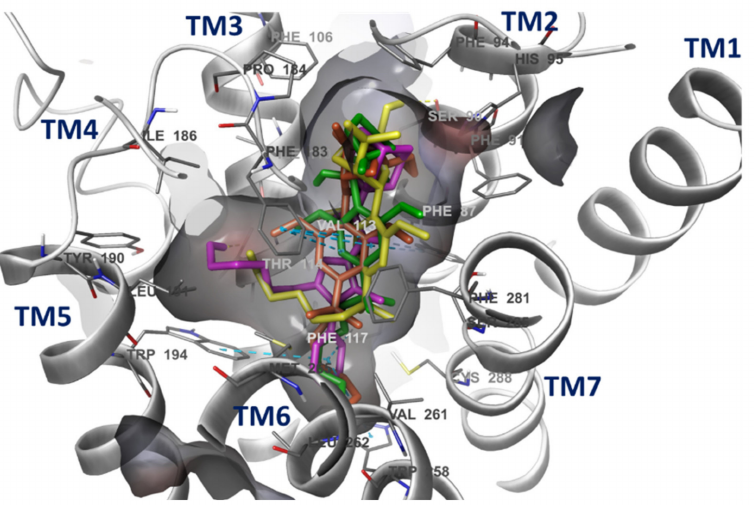
Figure 7. Orientation of docked ligands in the orthosteric site of CB2. The binding site of the CB2 cavity is represented by electrostatic potential surface. Ligands are shown in different colors; 5ZTY_ligand (pink), HU-308 (Yellow), HU-433 (Orange) and 1d (Green). TM means Transmembrane Helix. The residues of binding site and ligands are represented by thin and thick tubes, respectively. H-bonds and π – π interactions are represented by orange and cyan dotted lines,